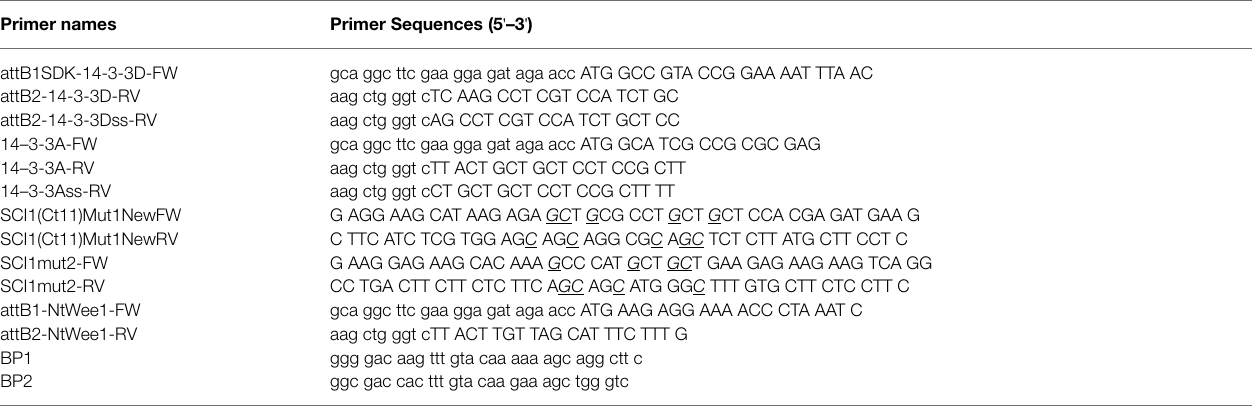
TABLE 1 | Primers used to amplify the coding regions of N. tabacum genes used in this